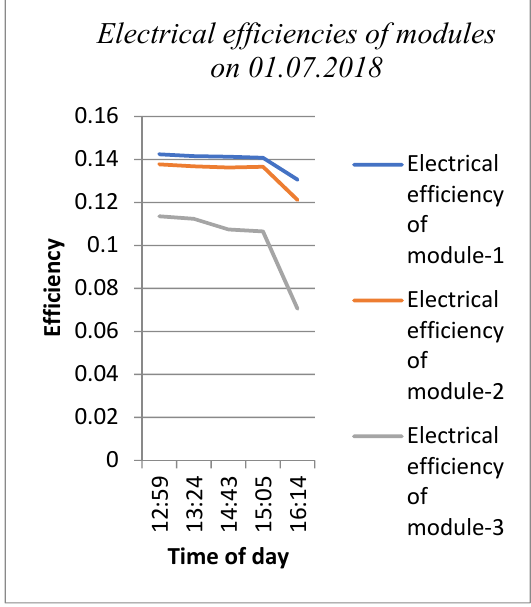
Figure 11. Electrical efficiencies ofmoduleson 01.07.2018.